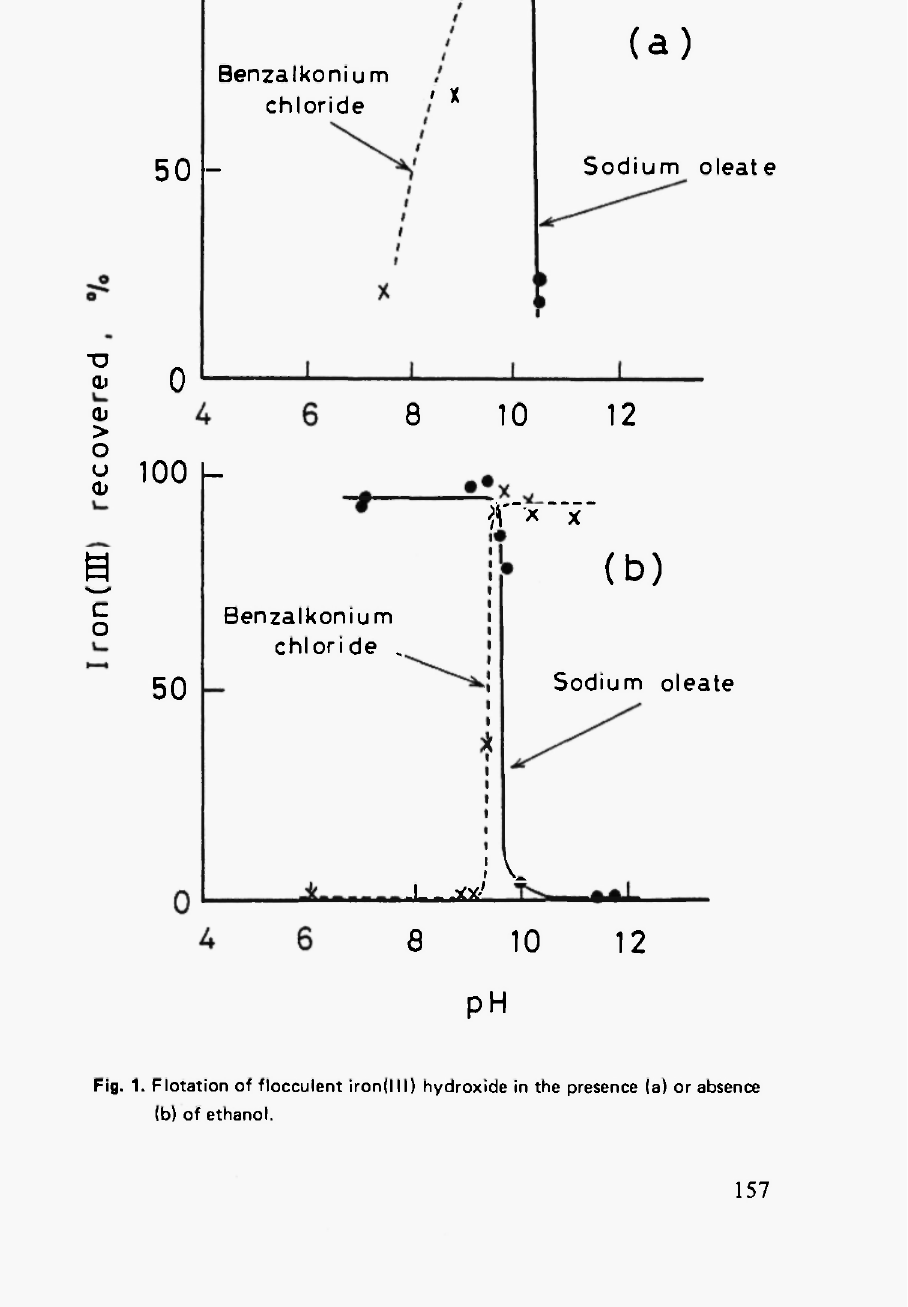
Fig. 1. Flotation of flocculent iron (III) hydroxide in the presence (a) or absence (b) of